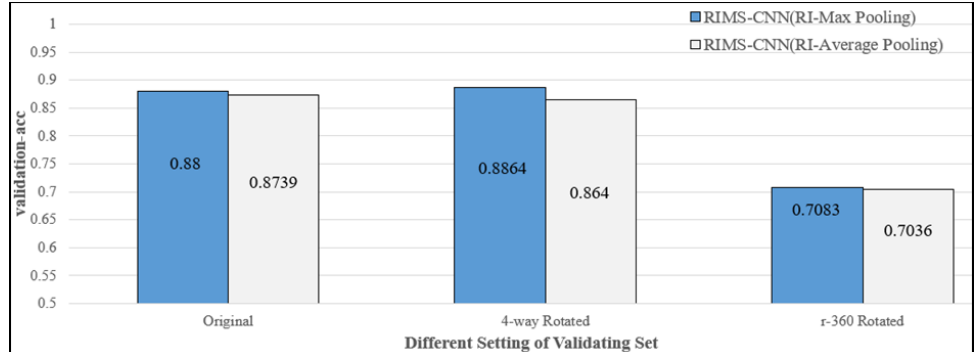
Figure 21. Comparing RI-max pooling with RI-average pooling in the different FASHION-MNIST settings.